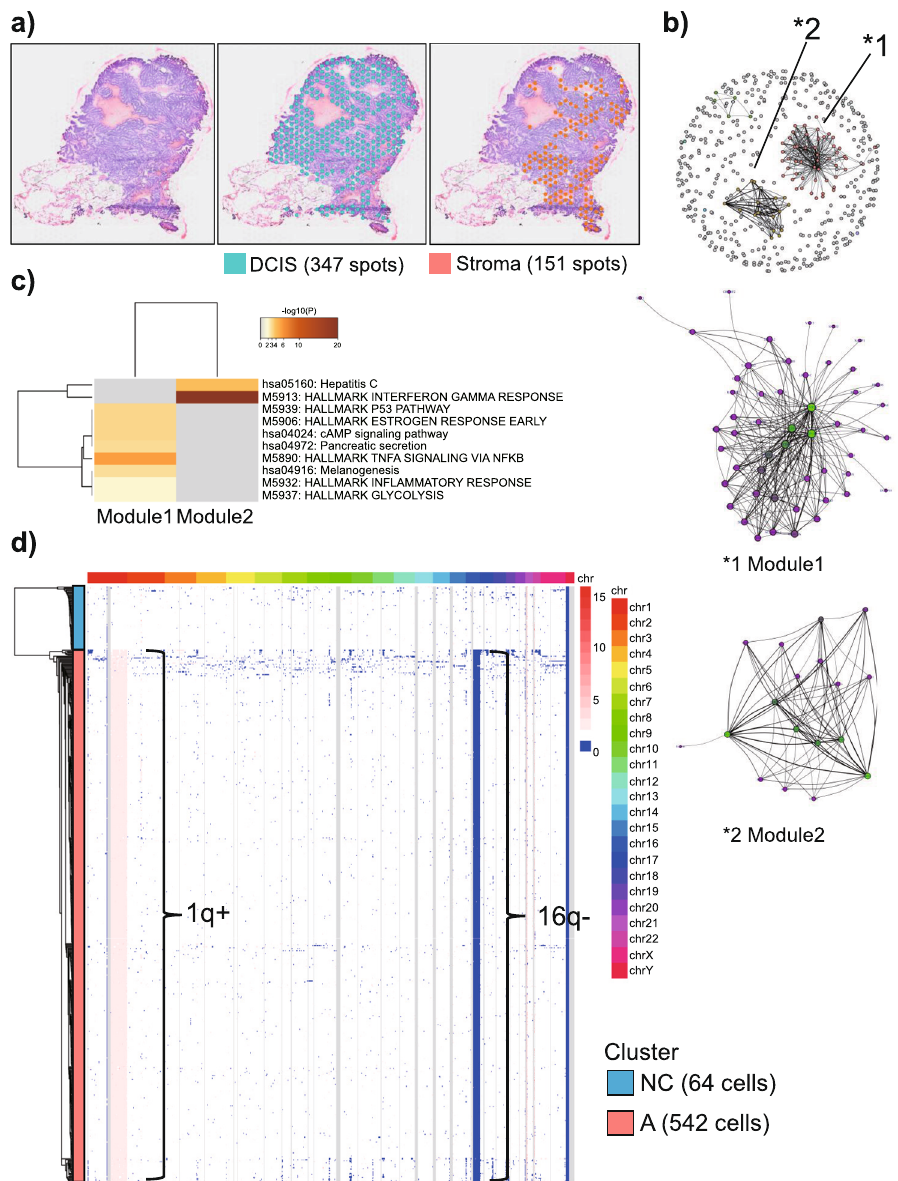
Fig. 5 Integrated spatial transcriptome and single-cell DNA sequencing analysis of a patient with PIK3CA mutation-positive ductal carcinoma in situ (DCIS) (Patient C). a Visualization of the Visium results for Patient C. Hematoxylin and eosin staining (left). The number of spots in the tissue was 594. Spots were classi fi ed into two clusters via unhierarchical k-means clustering. The clusters almost completely overlapped with morphologically identi fi ed cancer cells (middle panel) and noncancer cells (stromal cells, right panel). b Coexpression network analysis of transcriptomes in DCIS spots. Weighted gene coexpression network analysis was applied to build the coexpression network and identify gene modules. The nodes and edges indicate genes and signi fi cant correlations between genes, respectively. In the top panel, the two nodes that appeared to have changed from normal cells are indicated by asterisks. Middle and lower panels present the subnetworks in modules (*1) and (*2), respectively. Node centrality, de fi ned as the sum of strength, is represented by node size and color. c Pathway analysis was performed for each module using the Metascape tool. Each band represents one enriched term or pathway colored according to the − log 10 p value. Pathway enrichment analysis revealed that genes involved in p53 and estrogen signaling pathways were enriched in module 1, which shares the characteristics observed for the benign-appearing spots in Patients A and B, indicating that malignant transition had not occurred in this cancer. d Heatmap showing copy number variation at the single-cell level. The color scale for the copy number changes is shown at the right margin. The corresponding chromosomal locations are also shown. A total of 594 cells are represented. Clustering was performed as described in the “ Methods ” . Single-cell copy number variation analysis revealed two clusters, namely, clusters A and NC (noncancer). Cluster A features 1q + and 16q − structural variants and represents DCIS cells. Because cluster NC does not have a structural variant, it was considered to represent noncancer cells from Patient